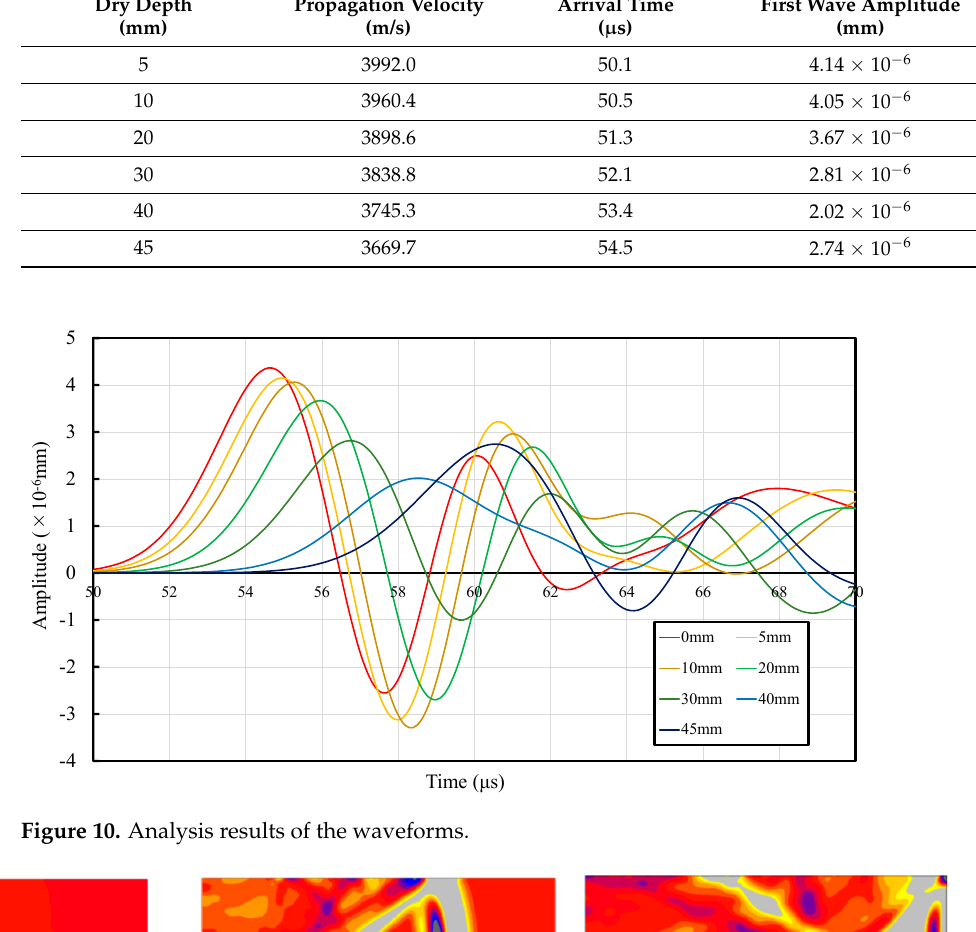
Figure 10. Analysis results of the waveforms.